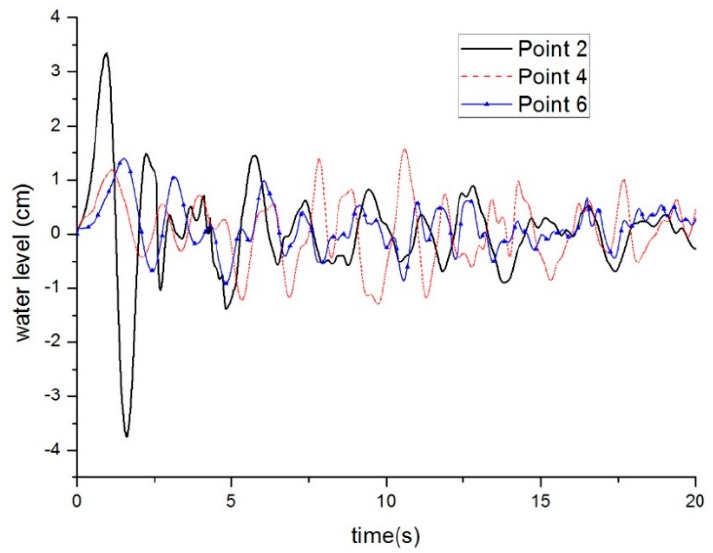
Figure 12. Variation curve of the case 7 water level in different positions.